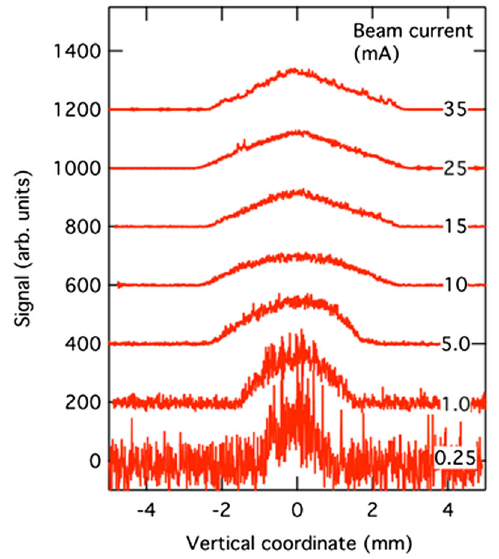
FIG. 11 (color online). Wire scans at different beam currents. Data are normalized to 1 mA